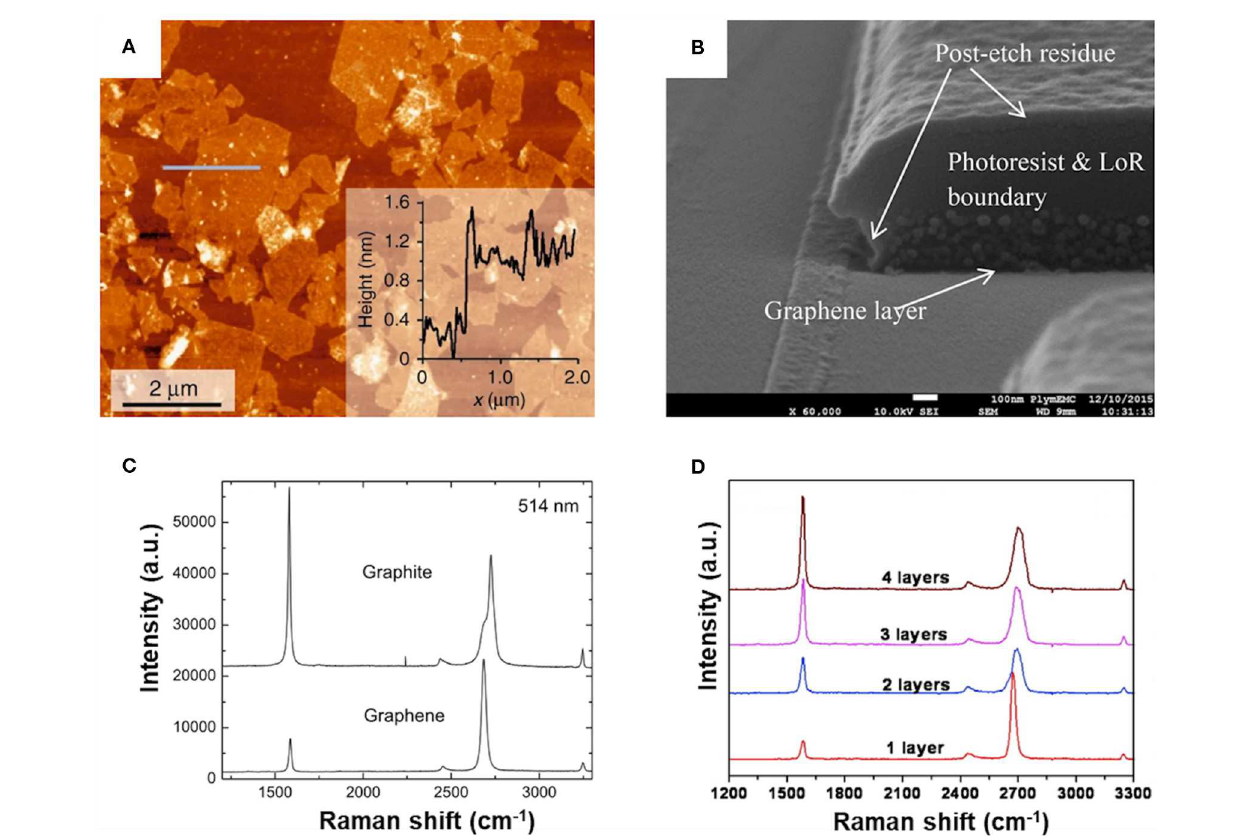
FIGURE 2 | (A) An AFM image of exfoliated graphene with corresponding height profile along the gray line . (B) A SEM image of a focused ion beam cross-section through a graphene layer. (C) The Raman spectra of graphite and graphene at 514nm. (D) The Raman spectra of graphene with a different number of layers